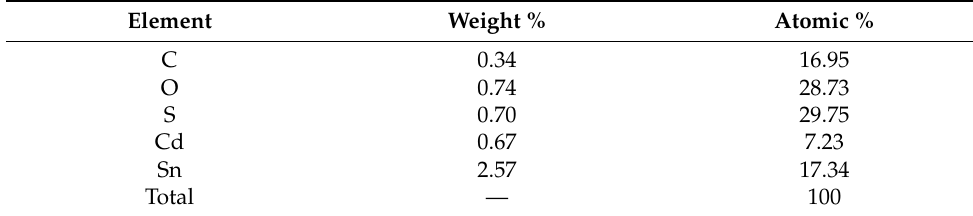
Table 1. The elemental content of CdS/SnS.